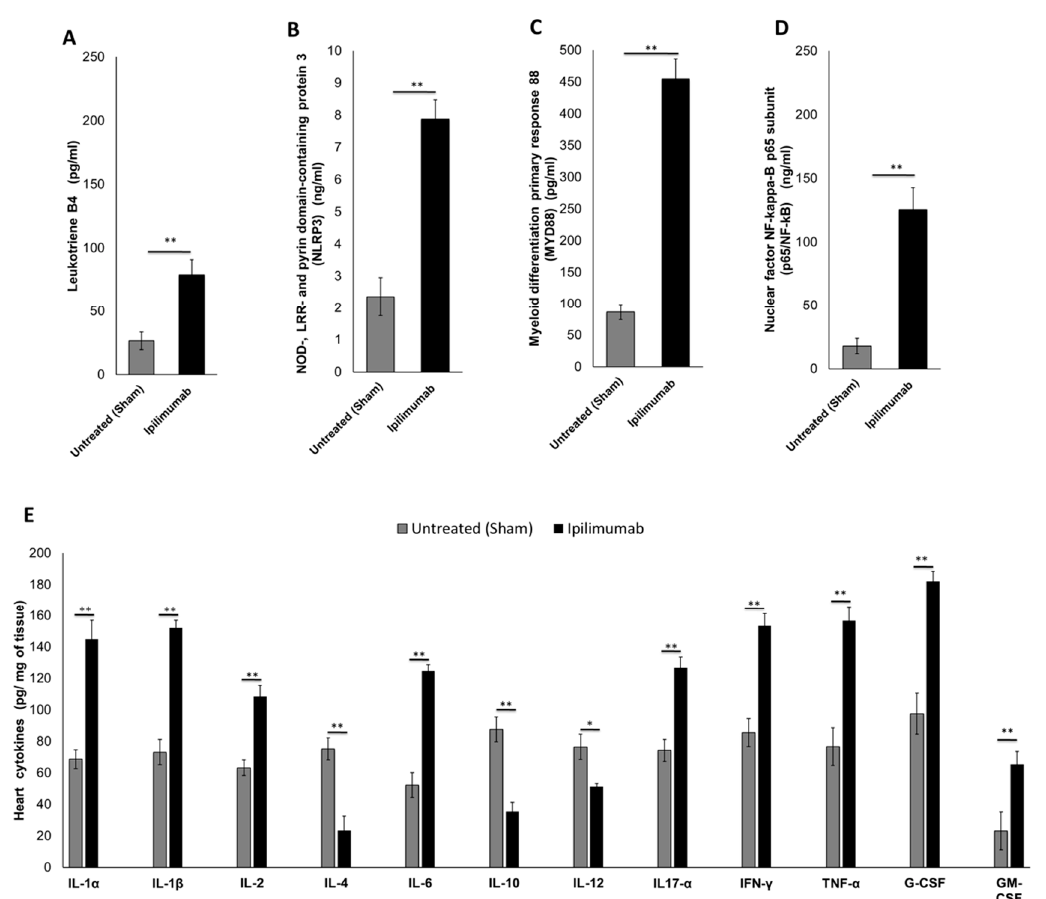
Figure 5. Inflammation pathways in the heart tissue of mice untreated (sham) or treated with Ipilimumab. Mice were treated as described in the Materials and Methods section; after their appropriate sacrifice, cardiac tissues were lysed and treated for quantitative analysis of leukotrienes B4 ( A ), nuclear factor NF-kappa-B p65 subunit ( B ), NLRP3 inflammasome ( C ), MYD88 ( D ), and 12 pro and anti-inflammatory cytokines ( E ). Error bars depict means ± SD. ** p < 0.01; * p < 0.05.; ns = not significant.